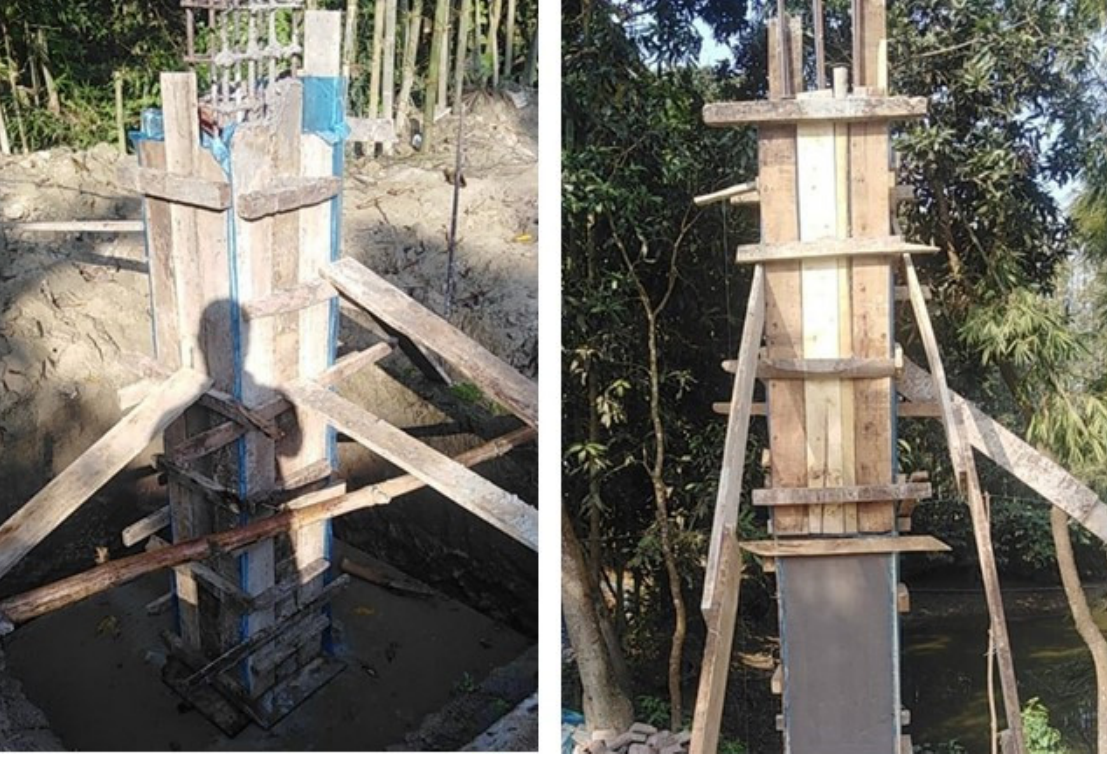
Figure 2. Lateral bracing of formwork for concrete columns (used with permission from Khadem [23]).